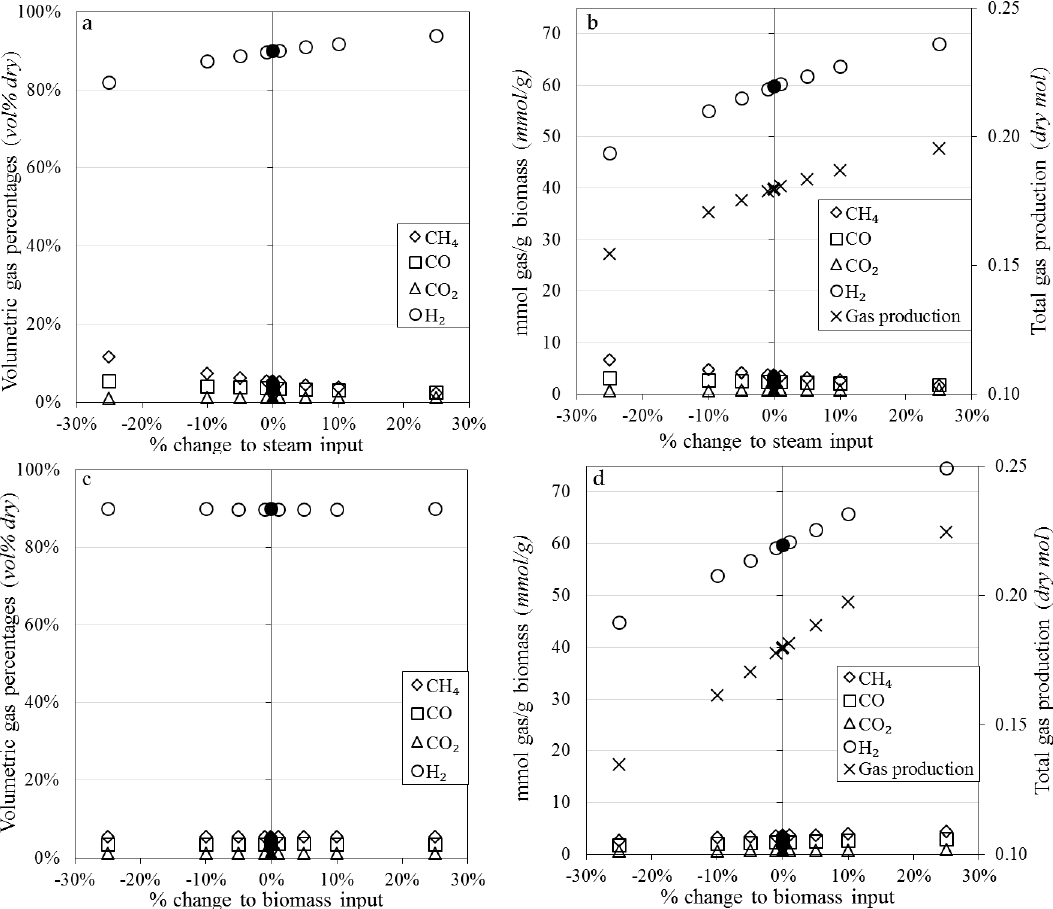
Figure 8. Sensitivity analysis conducted using modelling within FactSage. Figures on the top row ( a , b ) show the effect of varying the amount of steam fed into the reactor and the figures on the bottom row ( c , d ) indicate the effect varying the amount of biomass fed into the reactor.